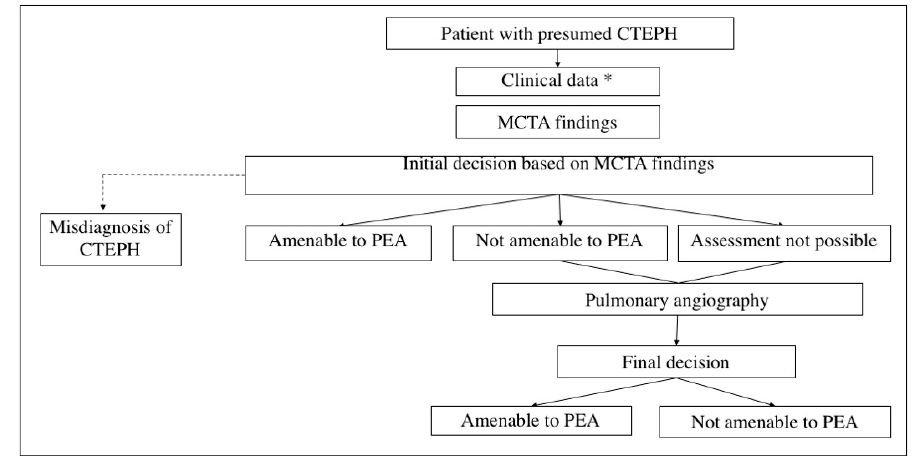
Figure 1. Patient flow assessment performed in the first pilot phase. Every patient was assessed with both multidetector computed tomographic angiography (MCTA) and pulmonary angiography (PA) at the multidisciplinary team (MDT) meeting ( A ). Patient flow assessment during the second “implementation” phase. PA was restricted to patients deemed inoperable based on CT or patients for whom assessment was not possible ( B ). CTEPH = chronic thromboembolic pulmonary hypertension; MCTA = multidetector computed tomographic angiography; PEA = pulmonary endarterectomy.